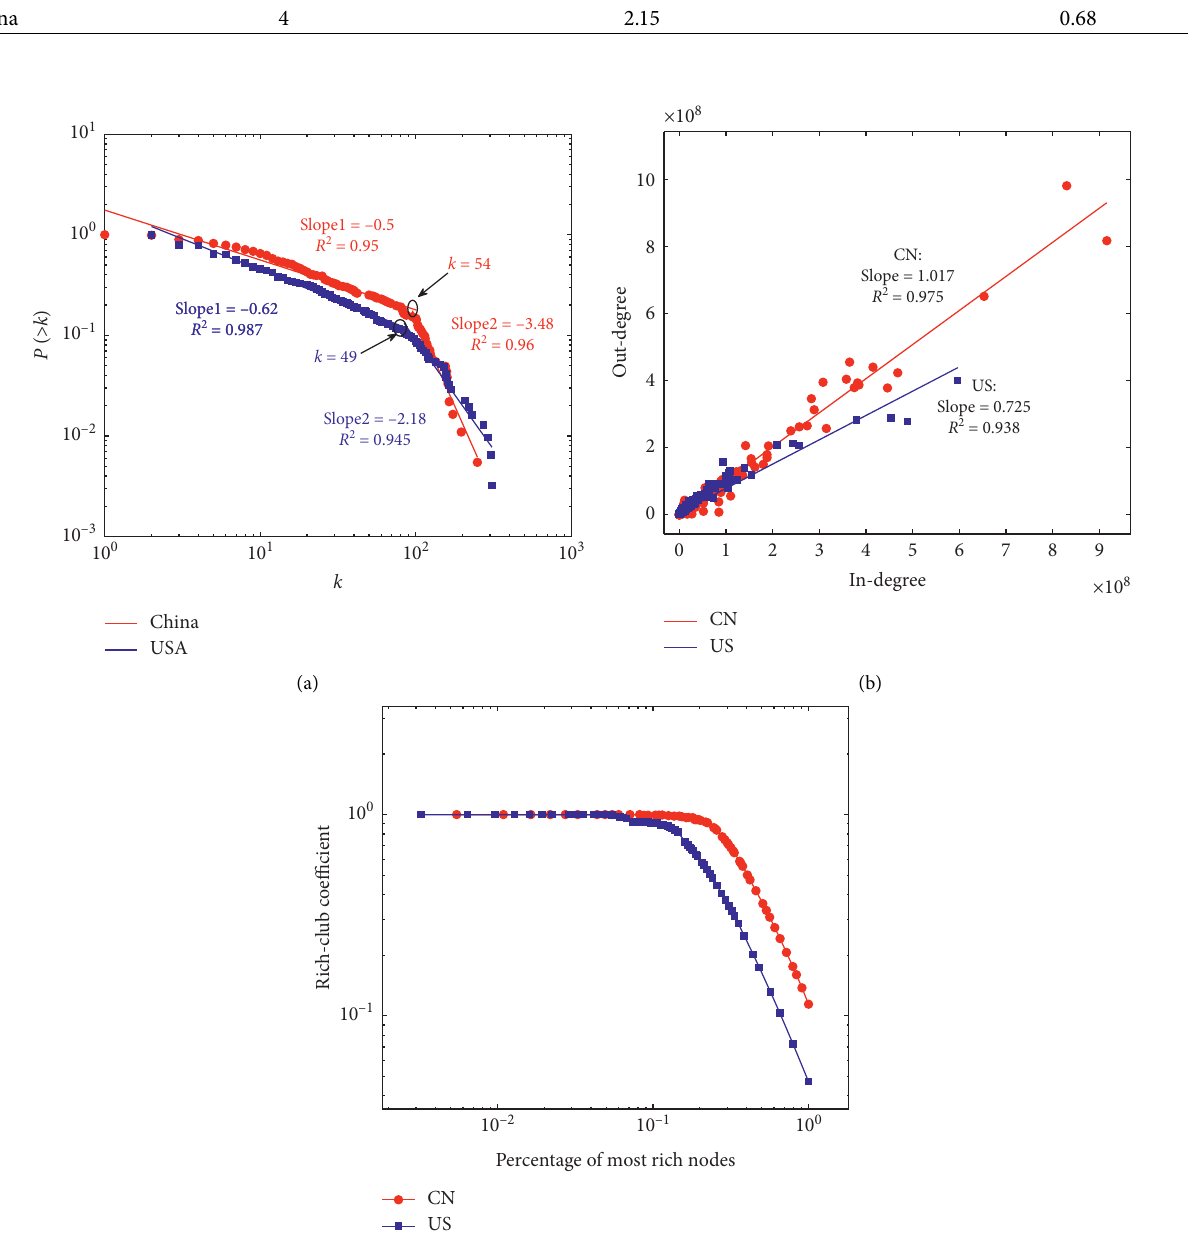
Figure 1: Comparisons on the properties of the US and China networks. (a) The degree distributions of the networks in log-log plot. (b) The relationship between in-degree and out-degree. (c) The rich-club coefficients.